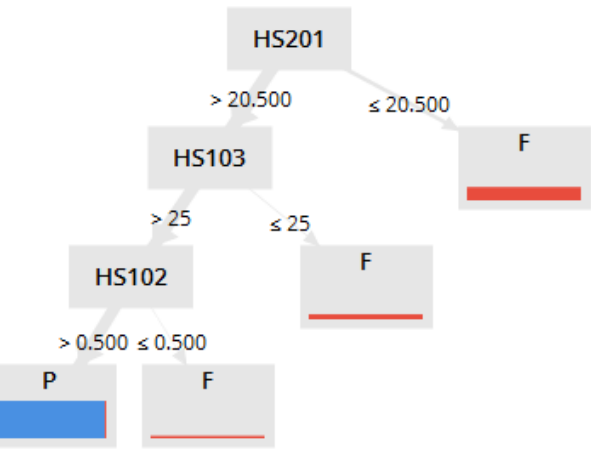
Fig. 11. Decision tree with gain ratio for dataset 2